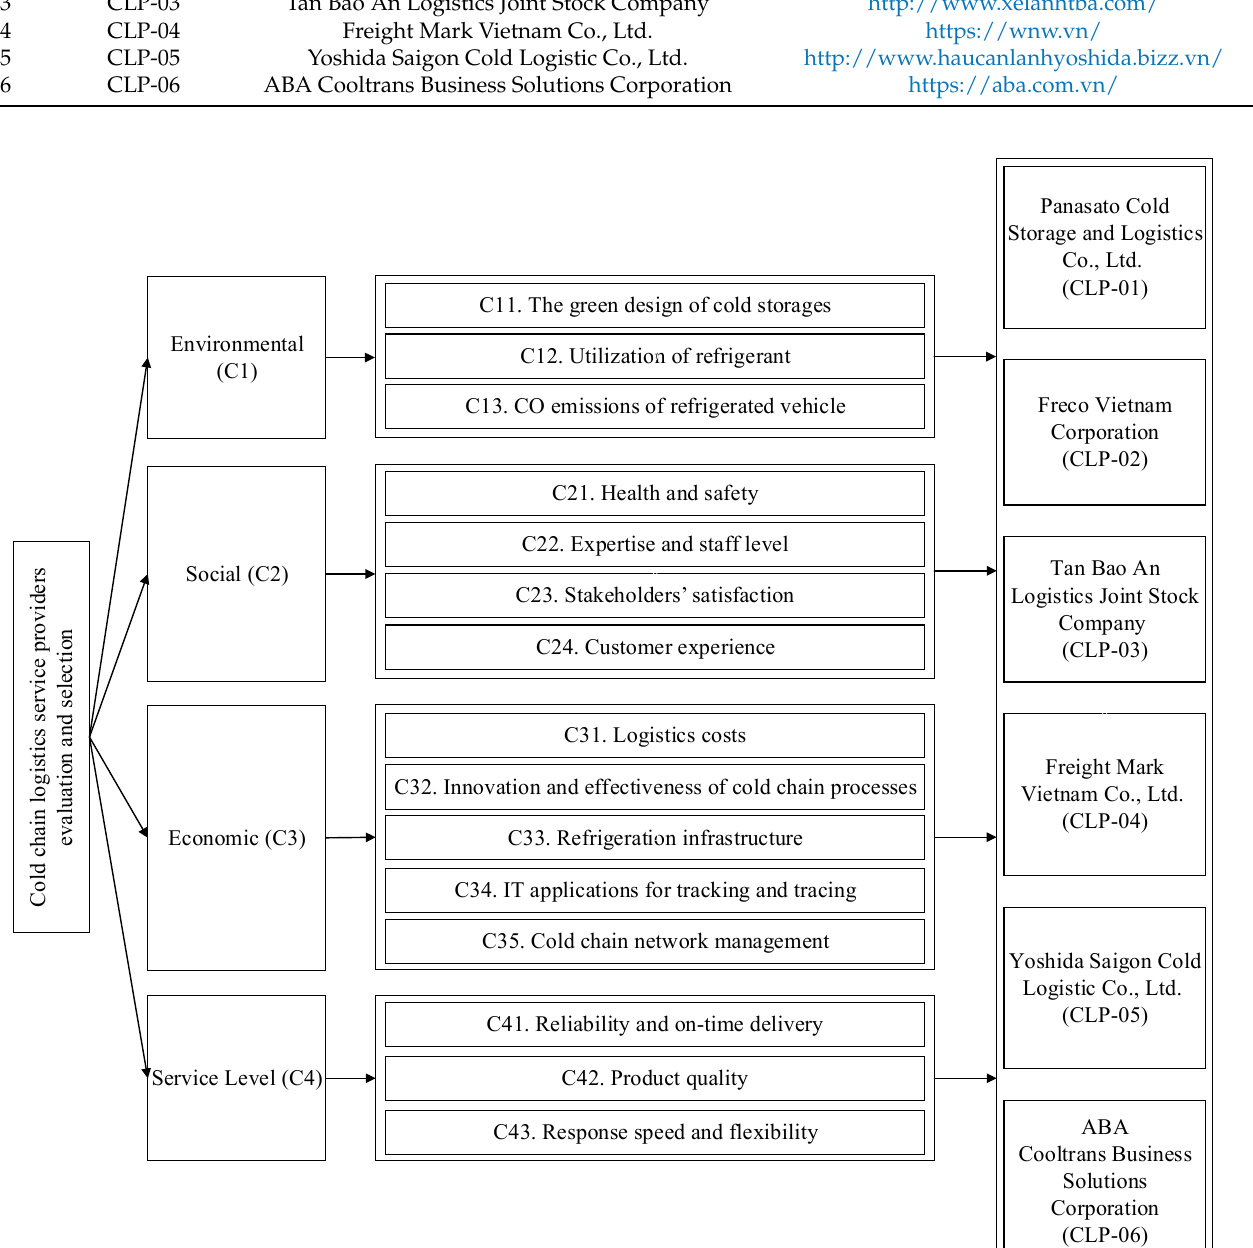
Figure 3. The hierarchical tree for evaluation of cold chain logistics service providers.